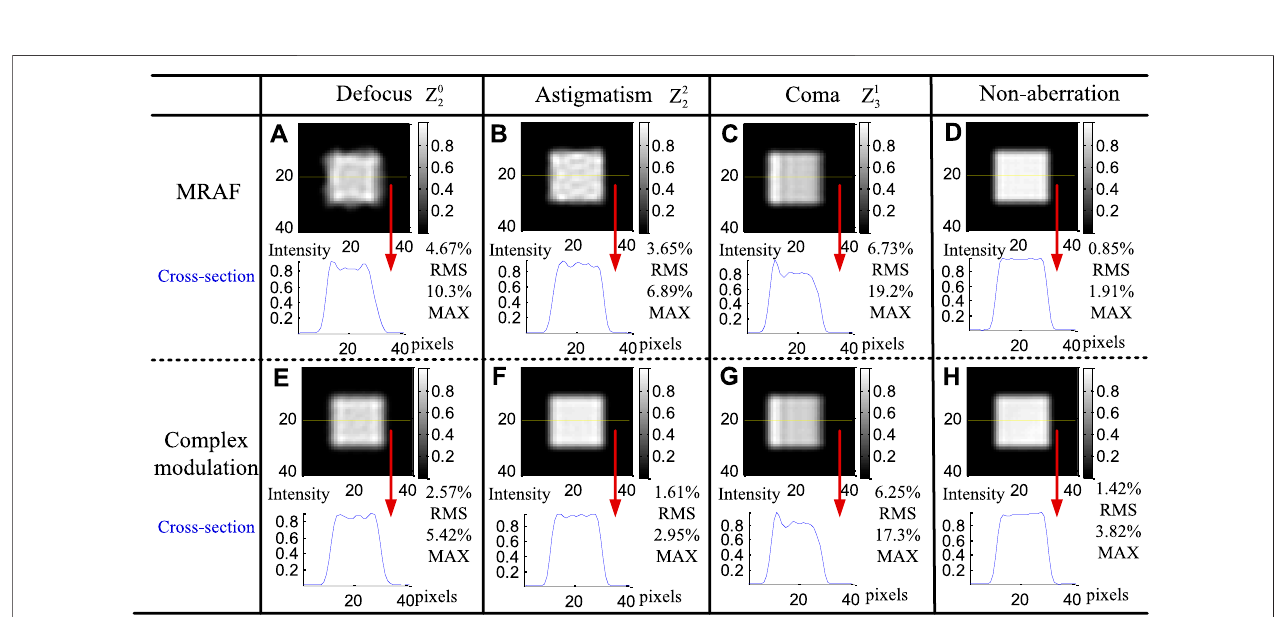
FIGURE 4 | Roughness analysis when the aberrations locate in the SLM and focal lens.